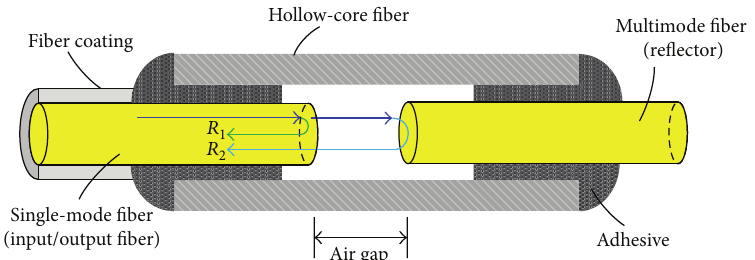
Figure 2: Measurement principal of EFPI